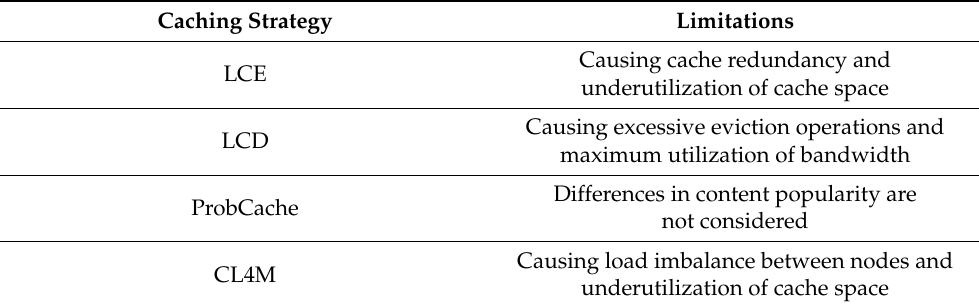
Table 3. Summary of limitations of the contrastive caching strategies.